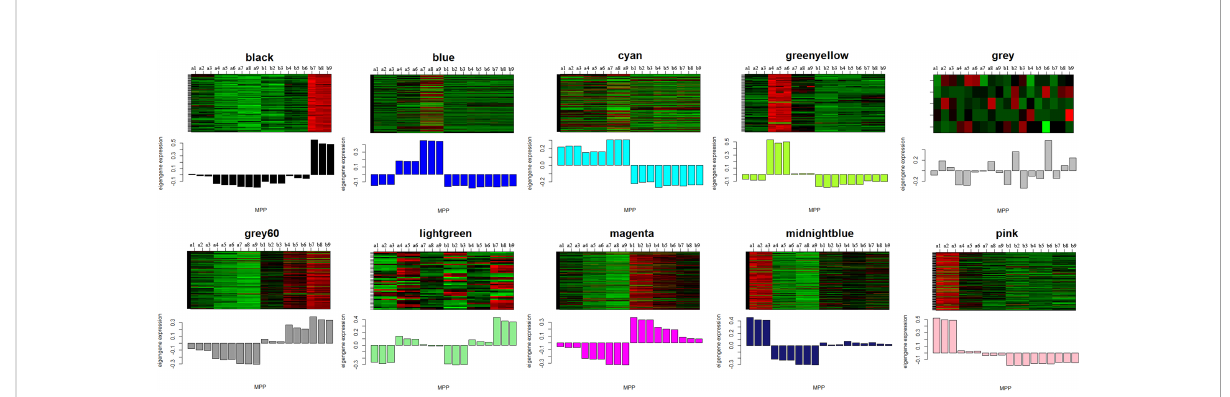
FIGURE 6 The eigengenes expression patterns and gene expression heatmap across samples for 10 identi fi ed modules. In heatmap, the letter a indicated W039, letter b represent W042. The numbers 1, 2 and 3 meant three biological repeats at the 15 DAP stage, 4, 5 and 6 showed three biological repeats at the 20 DAP stage, 7, 8 and 9 represented three biological repeats at the 25 DAP stage.